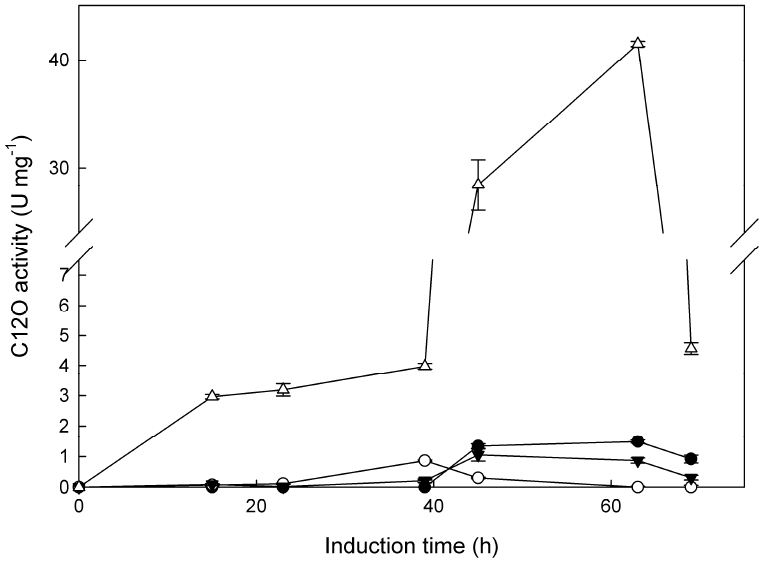
Figure 1. Time-course of the extracellular catechol 1,2-dioxygenase (C12O) activity expressed as U · mg − 1 of protein for the four selected strains, induced by 1 mM 2,4-DCP. Strains: Cladosporium sp. ML6-S1 ( ● ), Aspergillus sp. ML147-S2 ( ○ ), Penicillium chrysogenum ML156-S8 ( ▼ ), and Tritirachium sp. ML197-S3 ( ∆ ).